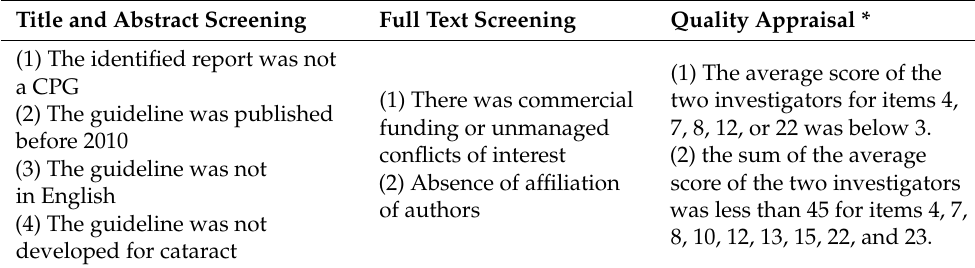
Table 1. Exclusion criteria for screening of Clinical Practice Guidelines